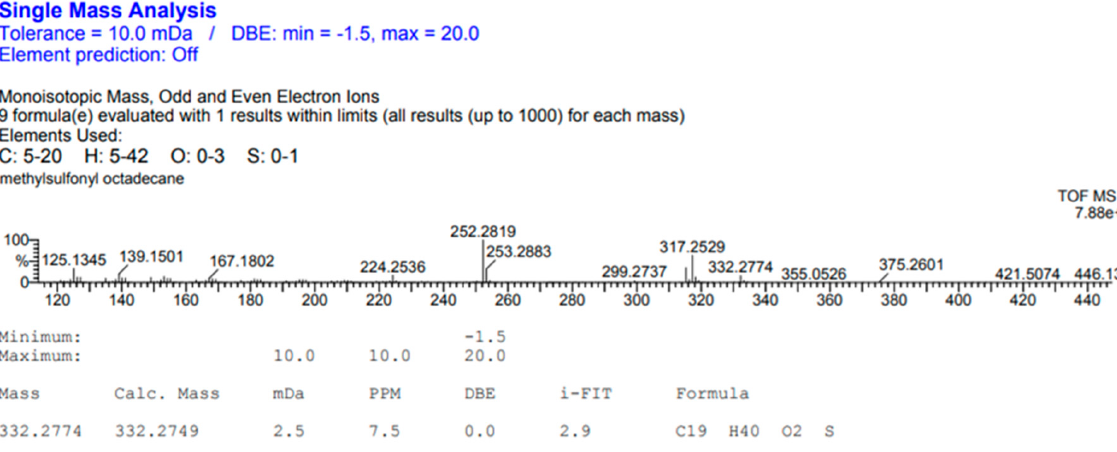
Figure A8. Mass spectrometry analysis for methylsulfonyloctadecane.